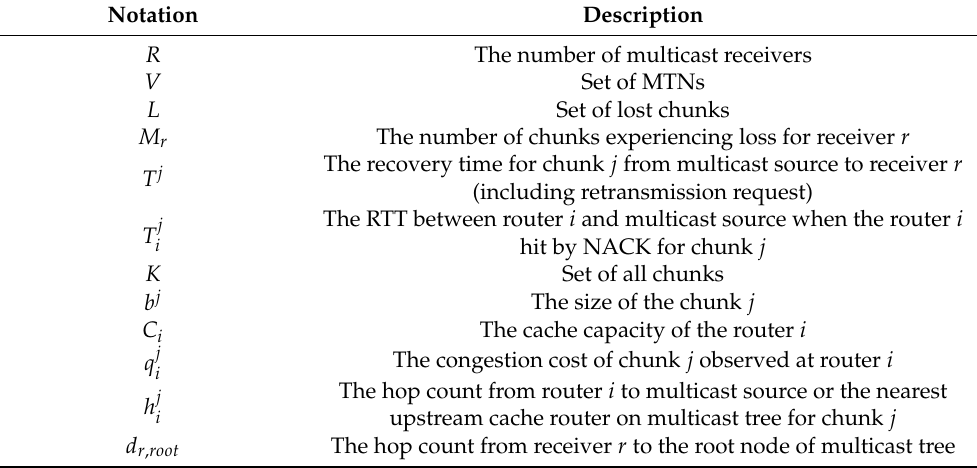
Table 2. Summary of the notations.